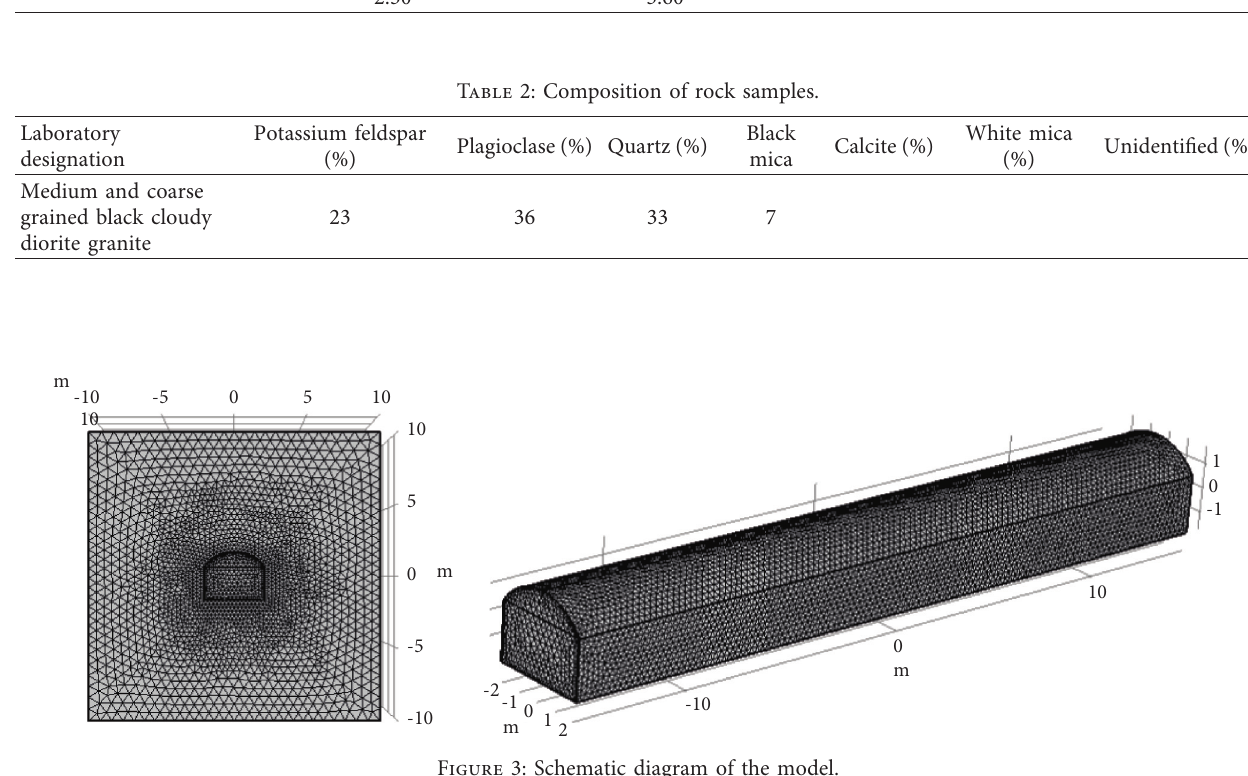
Figure 3: Schematic diagram of the